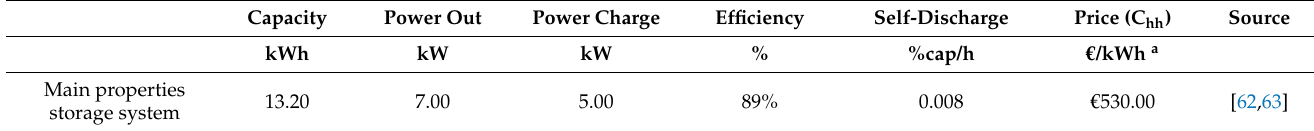
Table 3. The main properties of lithium battery storage.